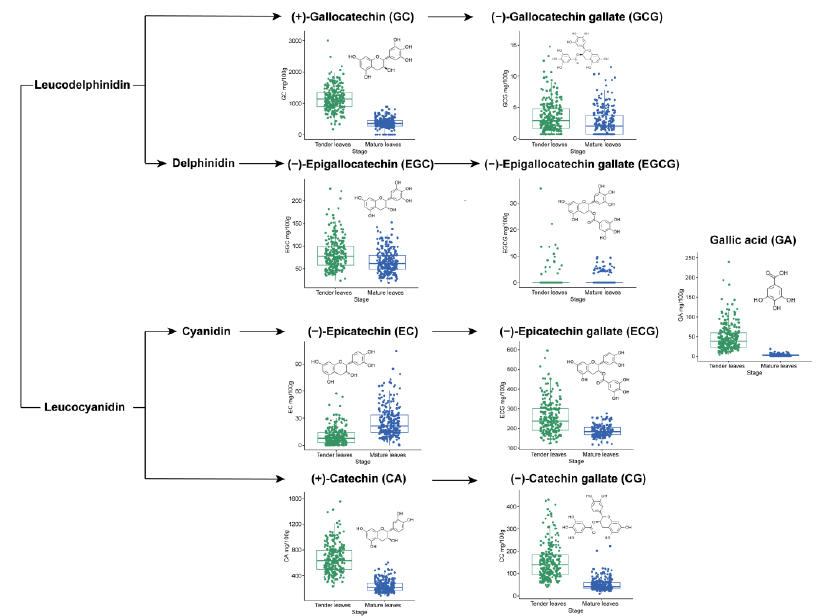
Figure 1. Content of catechins in young and adult leaves among 249 persimmon germplasms. The green ( left ) and blue ( right ) boxplots represent the catechin content in young and adult leaves, re- spectively.